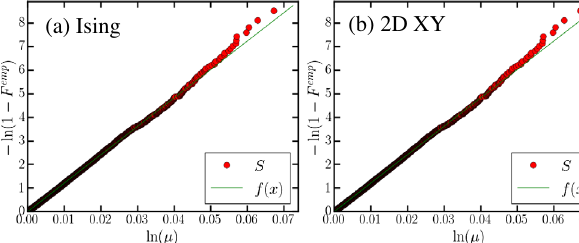
FIG. 11. Results of the two-NN method: fitting of the data points S for (a) Ising and (b) 2D XY thermal data sets generated close to the critical point [in panel (a), T ≈ 2 . 2 , while in panel (b), T ≈ 0 . 89 ]; in both cases, we consider L ¼ 40 , and the data set has N r ¼ 10 4 configurations. We obtain I d ≈ 47 and I d ≈ 120 ,